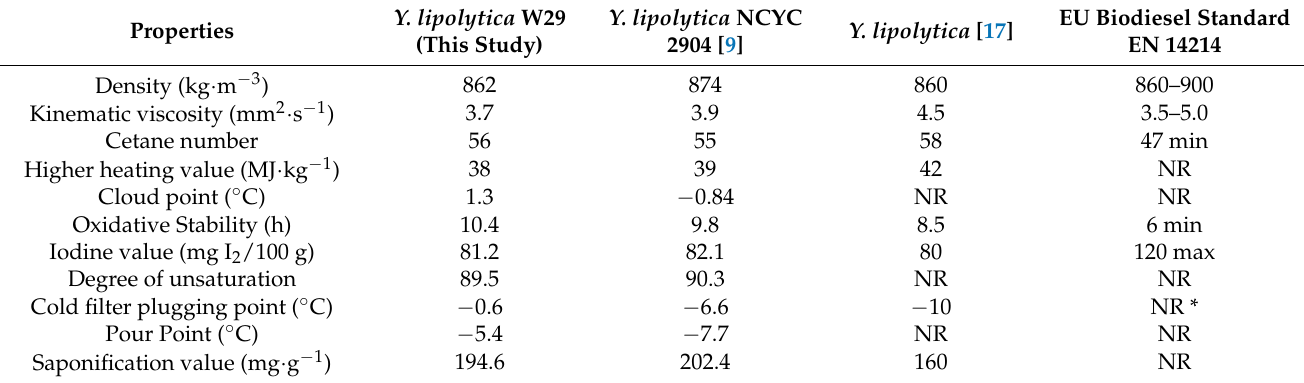
Table 2. Biodiesel properties obtained from Y. lipolytica W29 lipids estimated by the BiodieselAnalyzer© software, and comparison with other Y. lipolytica strains and the EU biodiesel standard EN